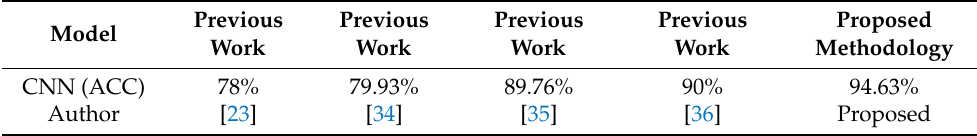
Table 7. Comparison of DL with State of